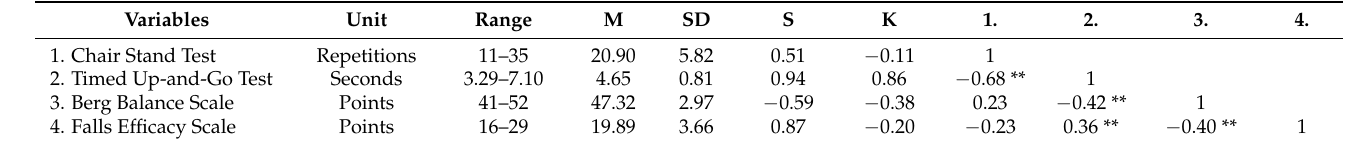
Table 1. Descriptive statistics and correlations.